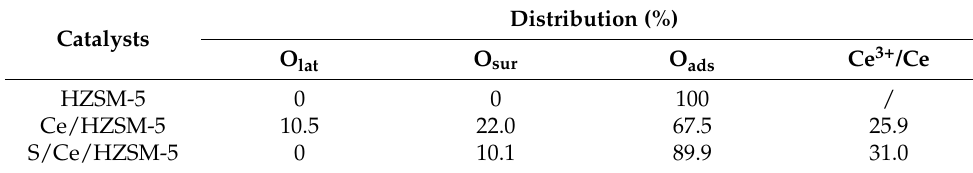
Figure 8. X-ray photo electron spectroscopy (XPS) spectra of catalyst, ( A ): S 2p for catalyst, ( B ): O 1s for catalysts, and ( C ): Ce 3d for catalysts. (1) HZSM-5, (2) Ce/HZSM-5, and (3) S/Ce/HZSM-5. Table 4. Surface atomic distribution of element O and Ce.